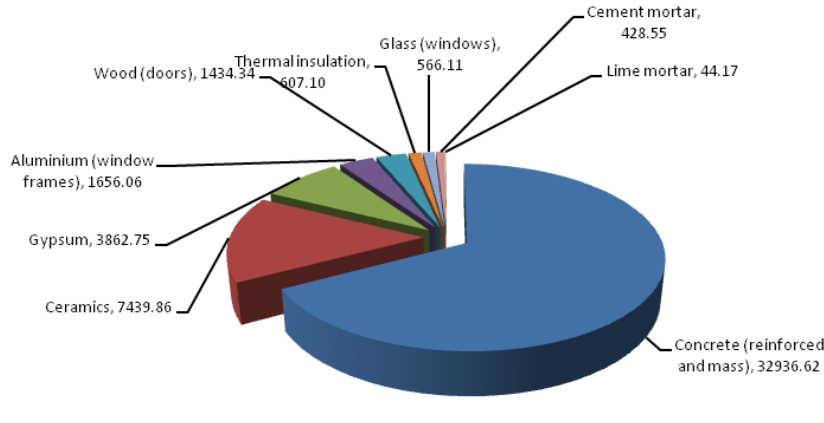
Figure 2. Cumulative primary energy demand (in GJ-Eq) in the manufacture of the different materials of the